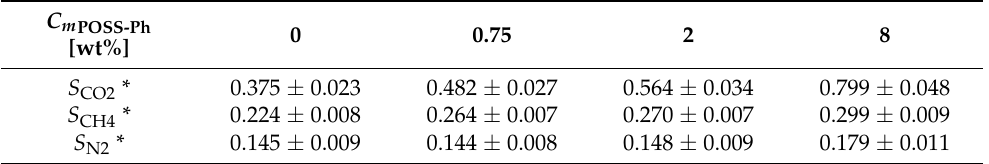
Table A10. Solubility coefficient S i for membranes of different POSS-Ph concentrations. * The values in table should be multiplied.